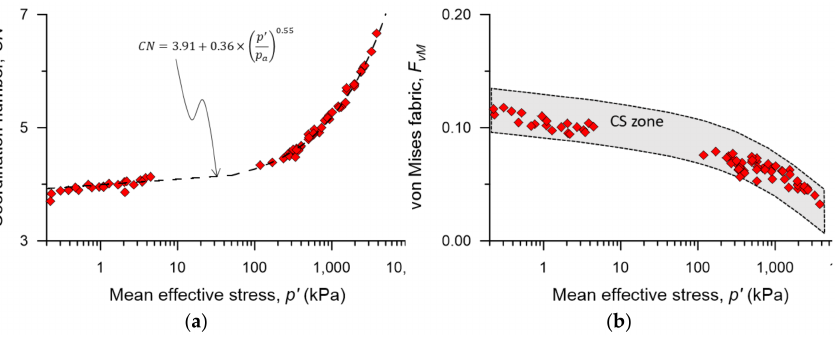
Figure 5. The critical state data from the undrained simulations in ( a ) CN -log( p (cid:48) ) and ( b ) F vM -log( p (cid:48) ) spaces.